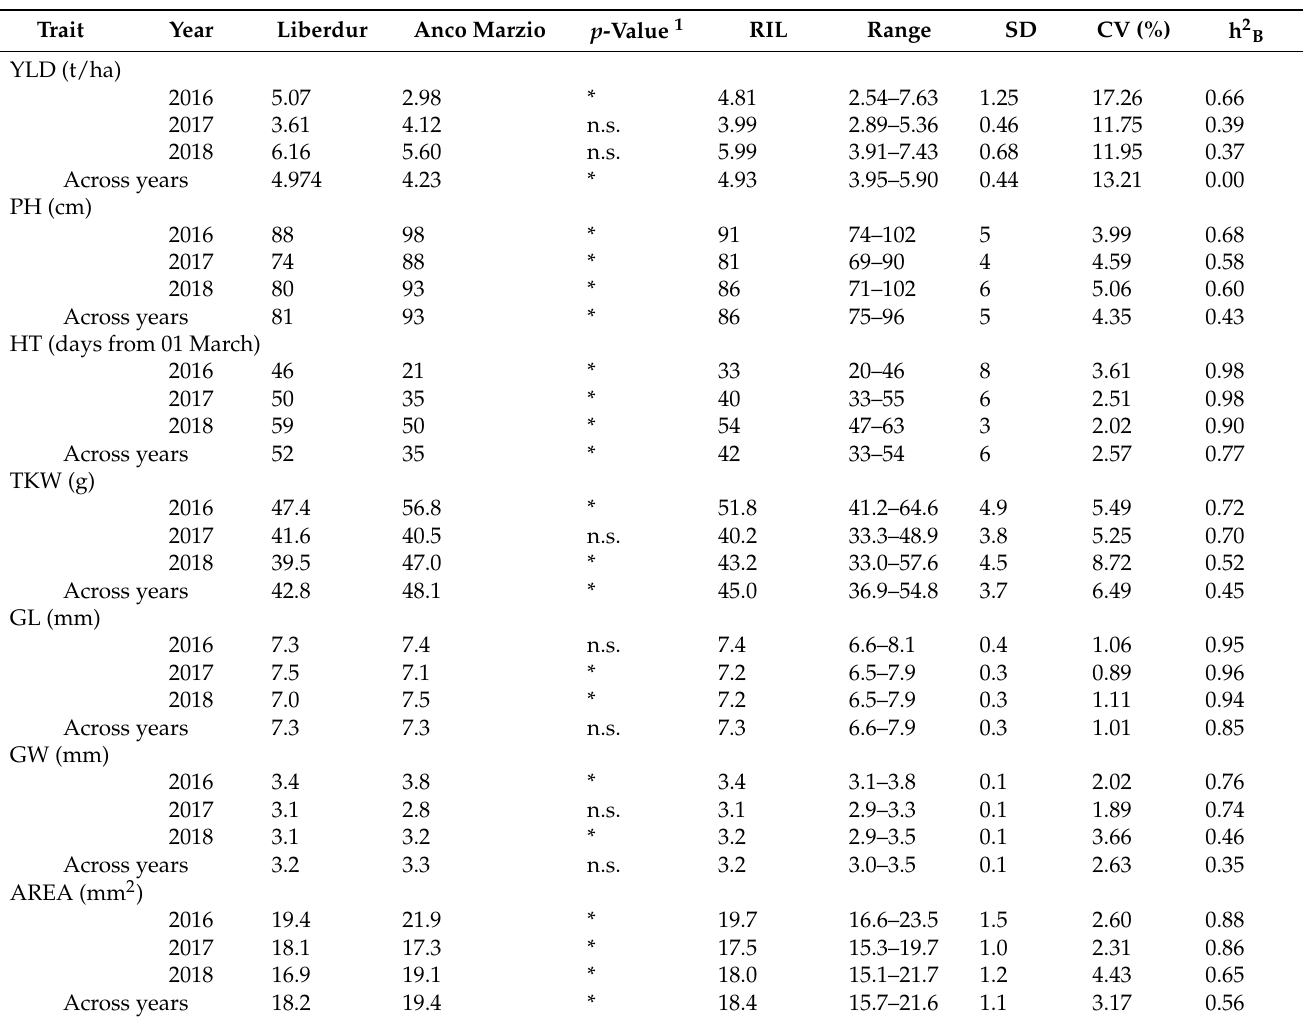
** and ***: significant differences at 0.01 p and 0.001 p , respectively. Mean values of Liberdur, Anco Marzio, and RILs in single season and across the three field trials are reported in Table 2. The two parents showed significant differences for HT, PH, AREA in all three seasons, and for TKW, GL and GW in two trials. In particular, Anco Marzio has generally larger grains compared to those of Liberdur. Table 2. Means, ranges, standard deviation (SD), coefficient of variation (CV), and heritability (h2B), of grain yield (YLD), plant height (PH), heading time (HT), thousand kernel weight (TKW), grain length (GL), grain width (GW), grain area (AREA) in the Liberdur x Anco Marzio RIL mapping population evaluated at Valenzano (Bari, Italy) for three years. Trait Year Liberdur Anco Marzio p -Value 1 RIL Range SD CV (%) h 2 B YLD (t/ha) 2016 2018 Across years